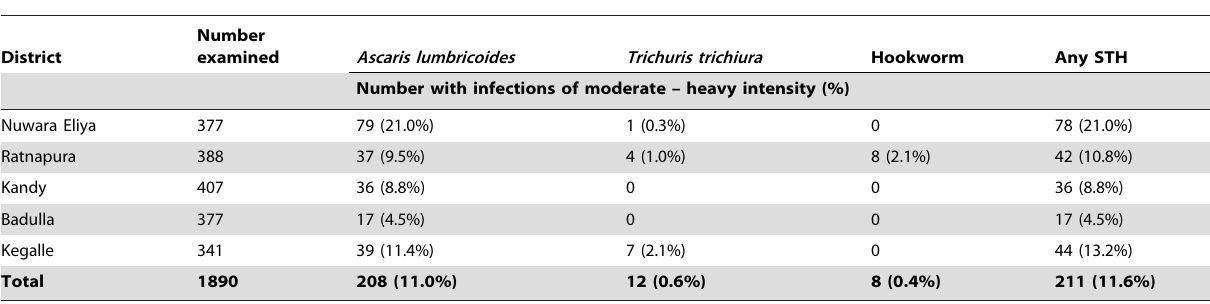
Table 2. Proportion of infections of moderate – heavy intensity by district.